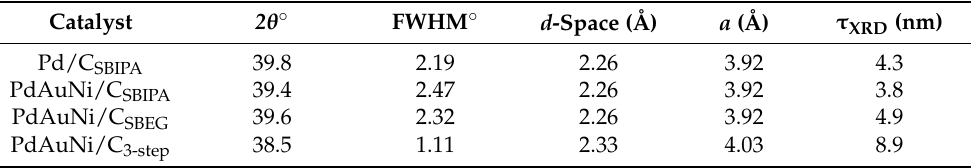
Table 1. Structural and morphological parameters of Pd/C SBIPA , PdAuNi/C SBIPA , PdAuNi/C SBEG , and PdAuNi/C 3-step